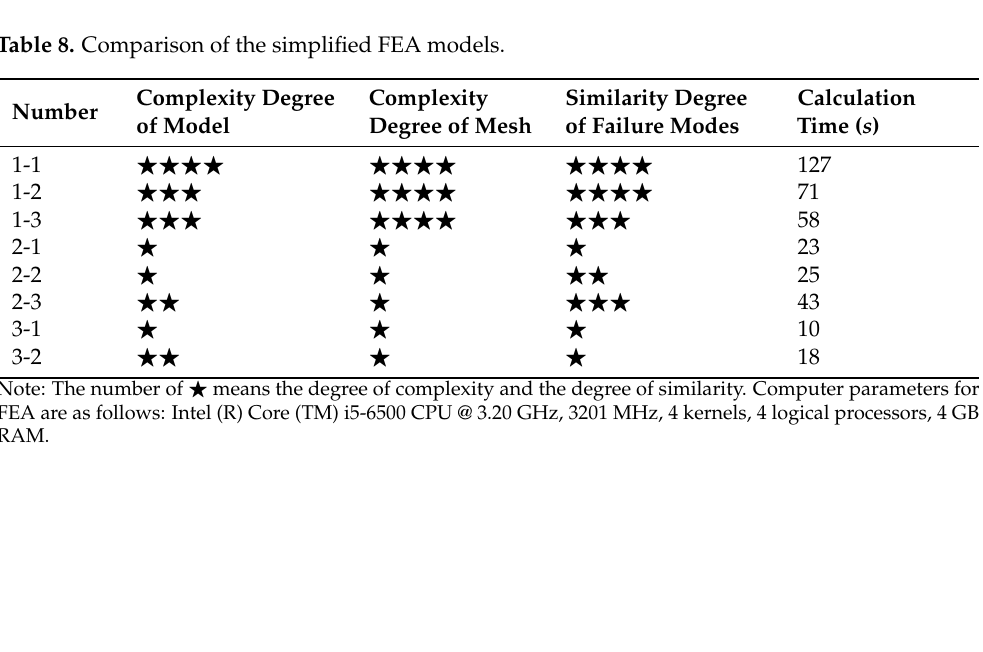
first type of simplified model, ( b ) second type of simplified model, ( c ) third type of simplified model.